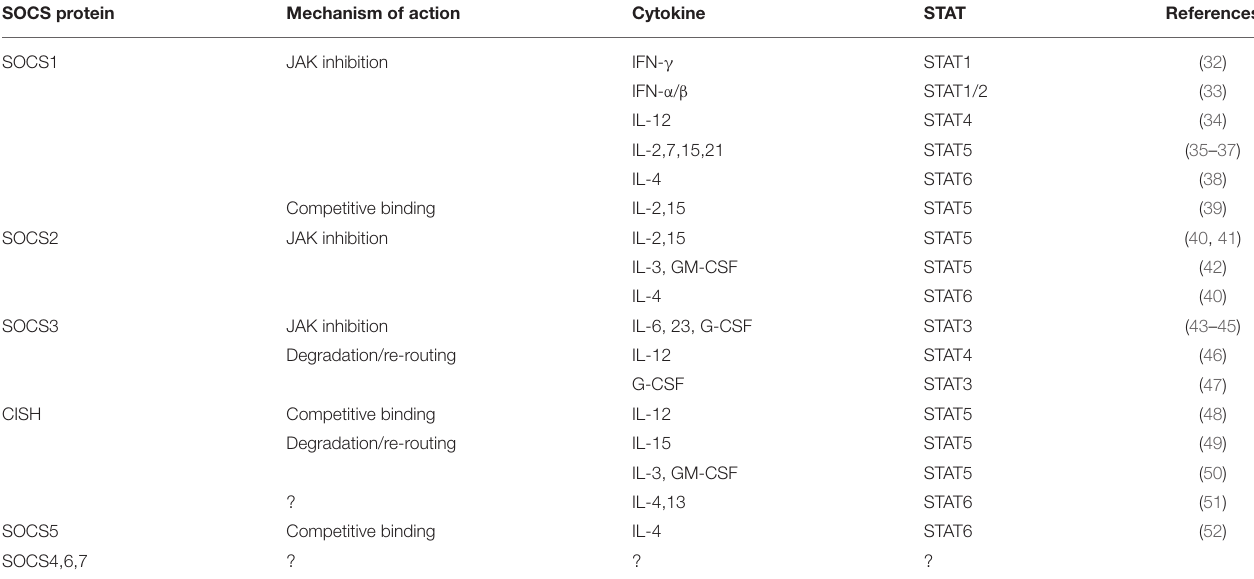
TABLE 1 | Mechanisms of SOCS action on cytokine signaling in immune